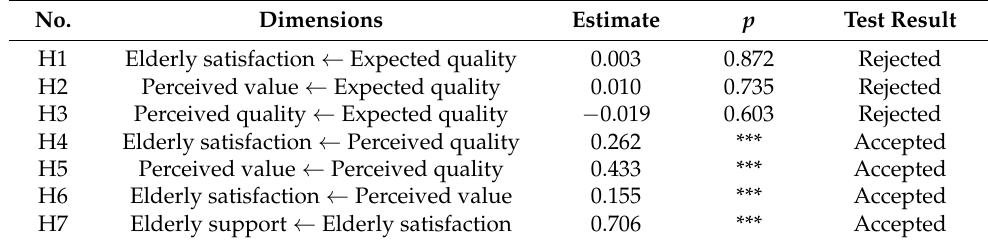
Table 8. Significance test of the path